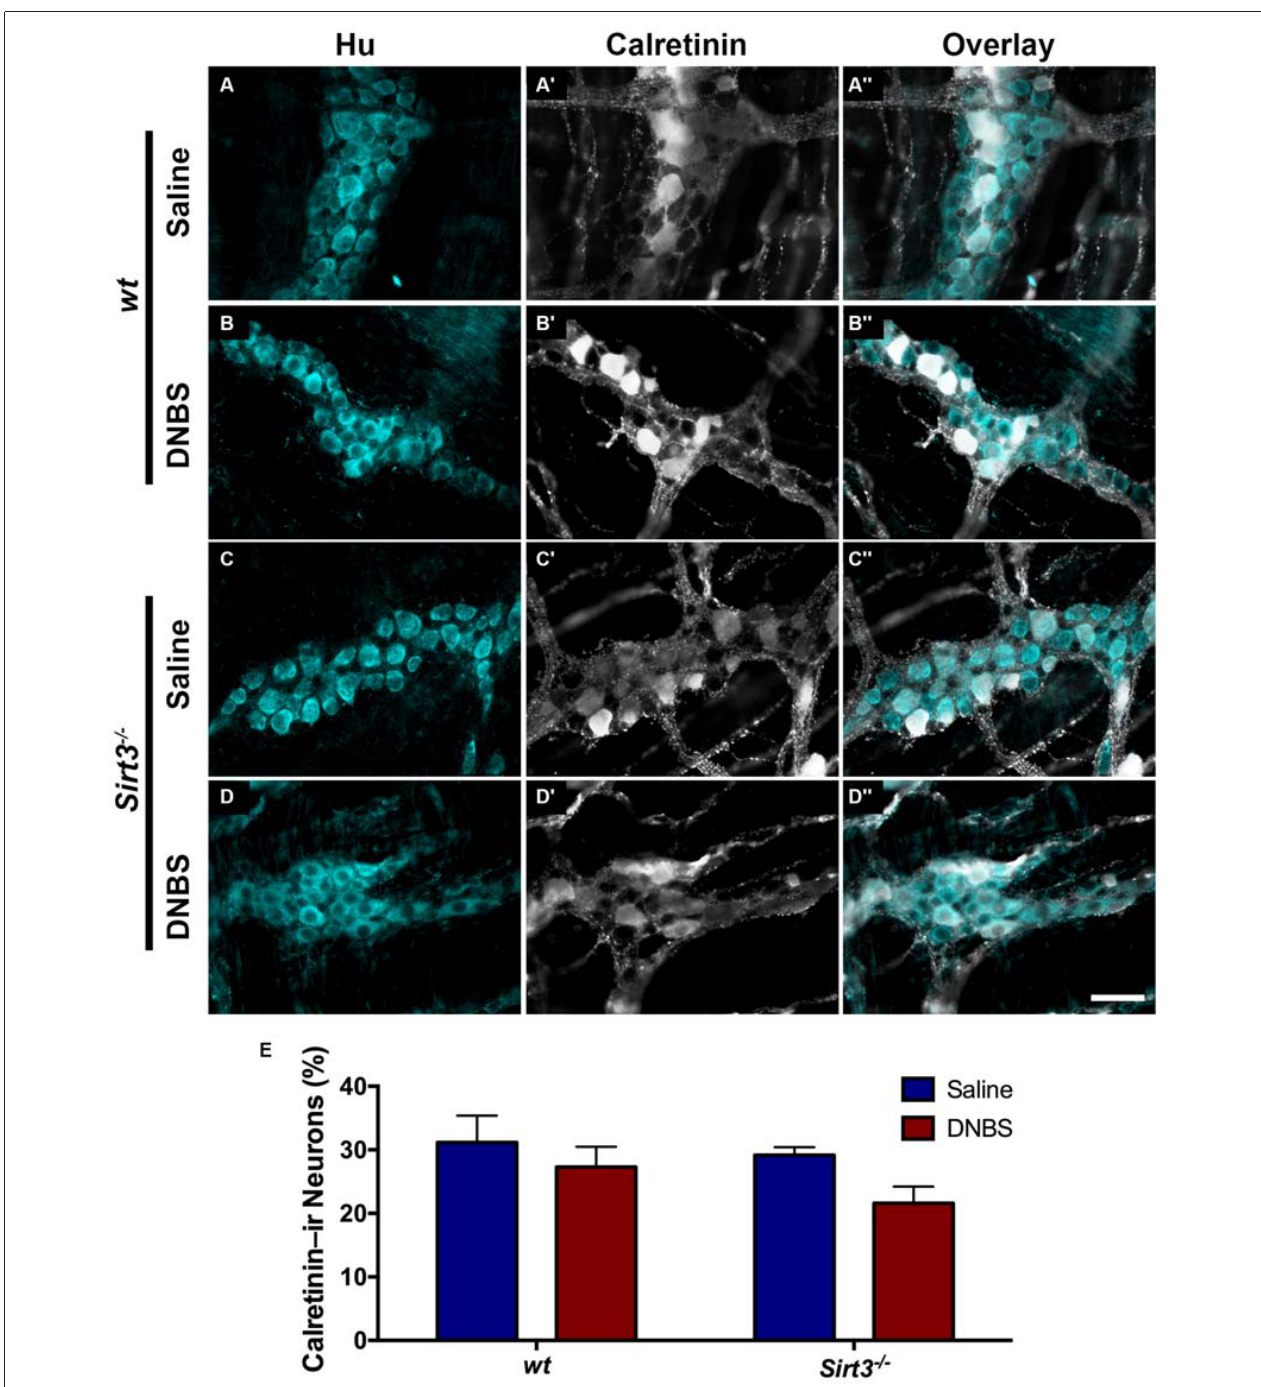
FIGURE 7 | The percentage of myenteric neurons that express calretinin is not altered by DNBS-colitis in wt or Sirt3 − / − mice. (A–D”) show dual-label fluorescence immunohistochemistry for HuC/D (cyan, A–D ) and calretinin (grayscale, A’–D’ ) in myenteric ganglia from saline- (A–A”, C–C”) or DNBS-treated (B–B”, D–D”) mice. Overlays are shown in (A”–D”) . Scale bar in D” = 50 µ m and applies to all images. (E) The percentage of HuC/D immunoreactive neurons that also display immunoreactivity for calretinin in healthy and inflamed mice with wt or Sirt3 − / − genotypes ( n = 4–5 animals per group, P > 0.05, 2-way ANOVA).